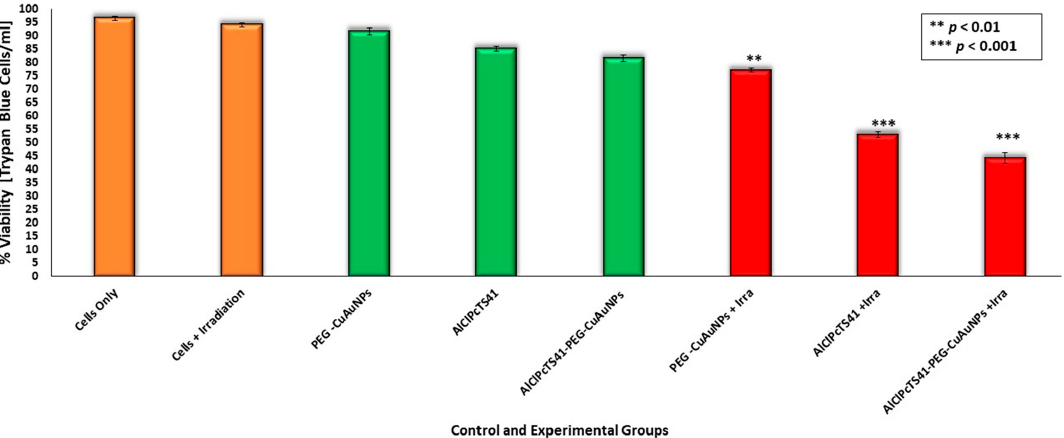
Figure 8. The viability of Caco-2 cells was assessed by trypan blue cell exclusion viability analysis. Caco-2 cells were subjected to laser treatment or without laser irradiation, (** p < 0.01, *** p < 0.001) shows statistical significance compared to cells only.